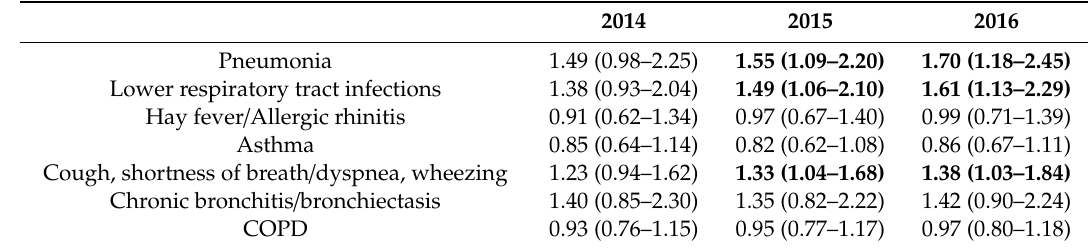
Table A7. Di ff erences (OR, 99% CI) a per year in various comorbid conditions between livestock dense areas and control areas among elderly b (statistically significant results in bold)